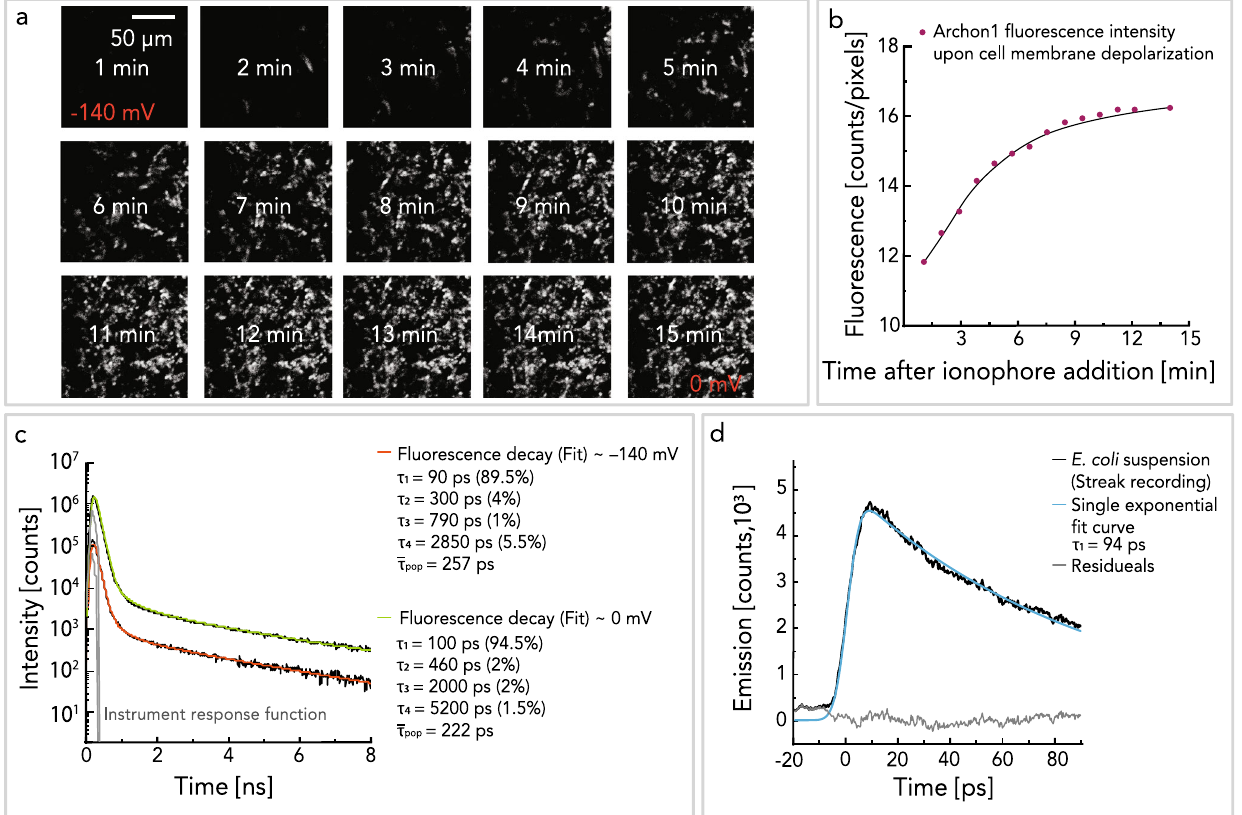
fl uorescence increase of the E. coli cells. The fi t with a Hill-model yield a time constant of ~4 min for gramicidin-based membrane depolarization. c The corresponding fl uorescence lifetime fi ts before and 15 min after the addition of the ionophore. The fi t results and the mean fl uorescence lifetime (cid:1) τ pop are given on the right side of the panel. d The fl uorescence (after 625 nm exci- tation) of Archon1 overexpressed in E. coli suspension was recorded with a Streak camera setup (3 – 4 ps time resolution). The fl uorescence decay could be described by a single exponential function (blue) with τ 1 = 94 ps. Source data are provided in the Source Data fi le ( b – d